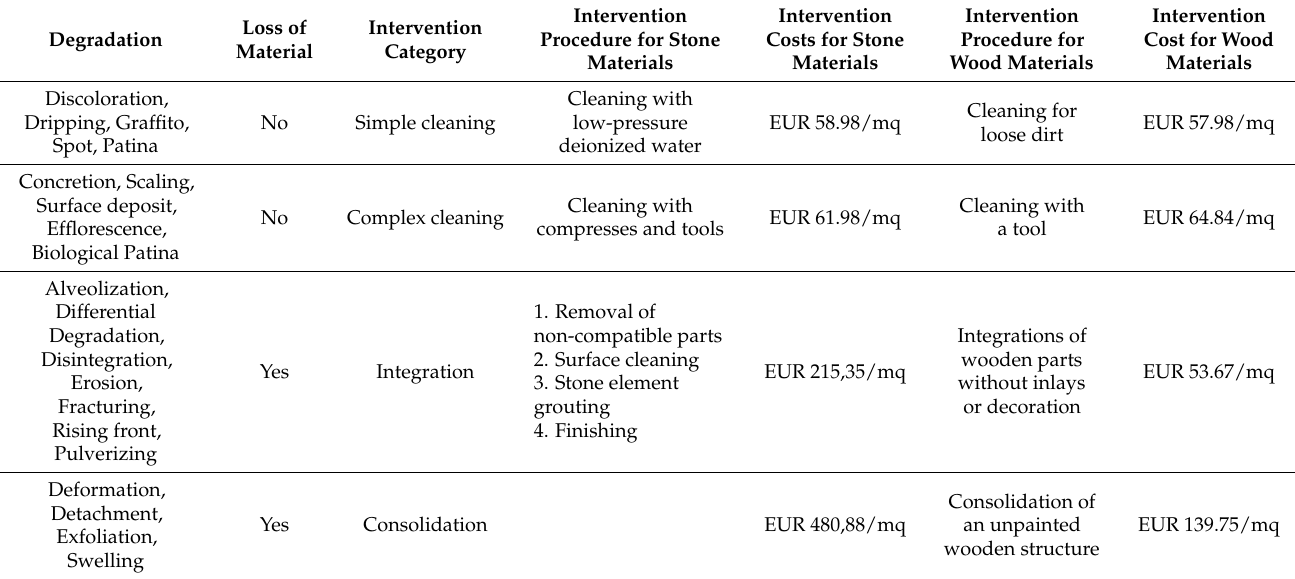
Table 3. Intervention procedure and costs (stone and wood